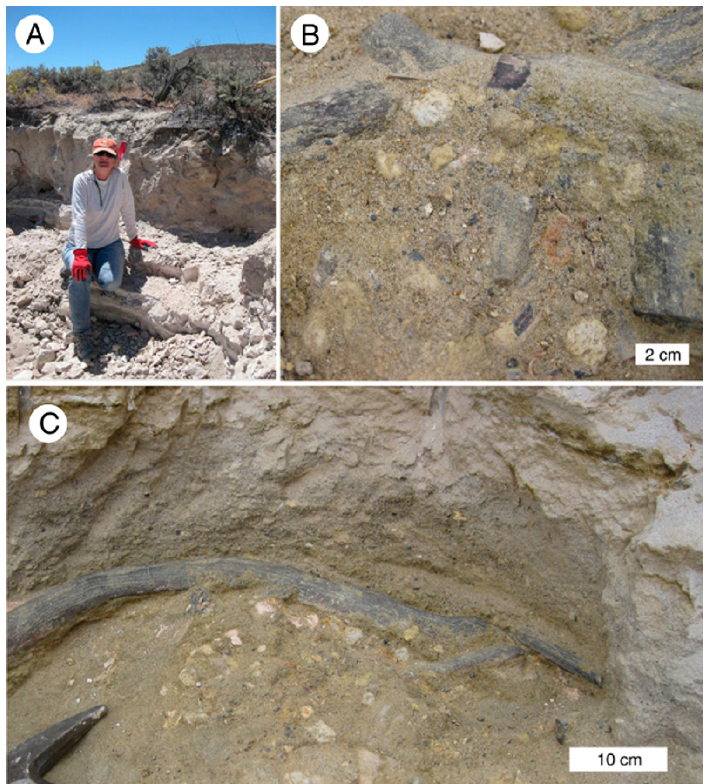
Figure 5. Bruneau Woodpile site. ( A ) Revealing the wood-bearing stratum requires excavation of one meter of cemented sediment; ( B ) Limb sections and trunk fragments occur in a weakly cemented sandstone bed that contains large pumice clasts. Some wood specimens have a thin black exterior coating composed of manganese oxide, as evidenced by SEM/EDS analysis; ( C ) The wood-bearing layer is overlain by a ~7 cm white fine sandy ash with parallel laminations. Note the abundance of pumice clasts in the sandy sediment below the elongate fossil twig.